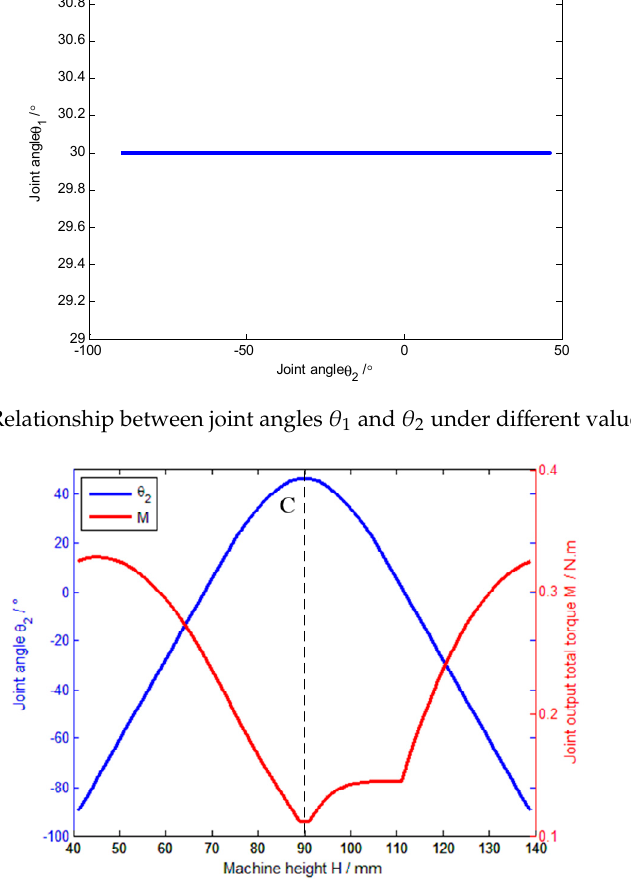
Figure 12. Minimum of M under different center of gravity heights.